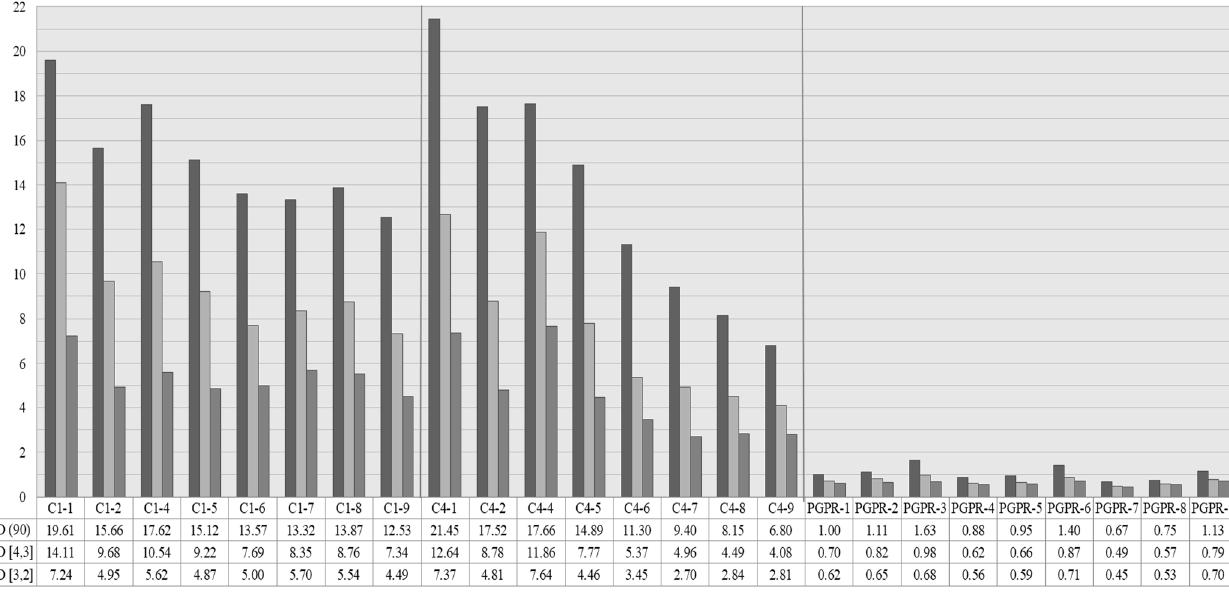
Figure 5. The droplet size parameters for W/O emulsions were prepared with different emulsifiers and formulations.